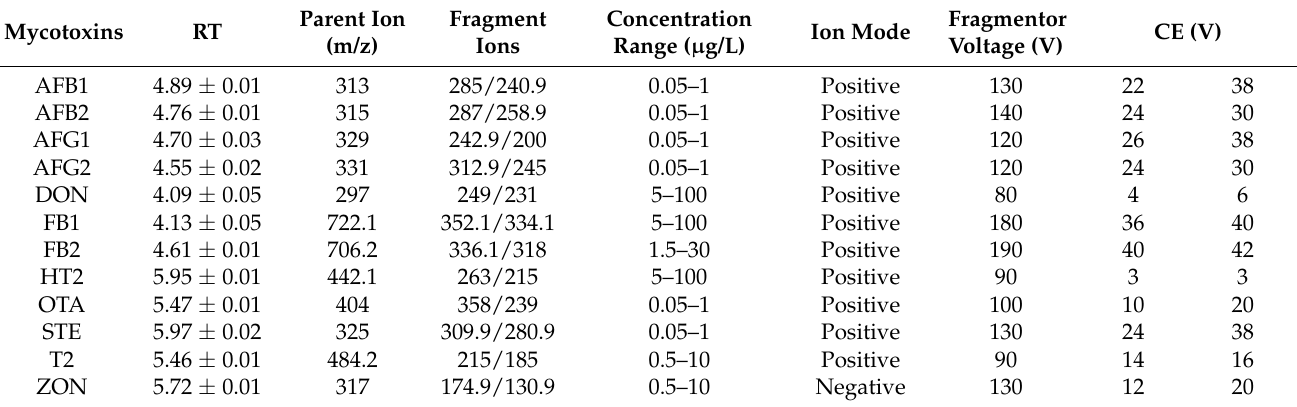
Table 7. Optimized MS/MS parameters for the